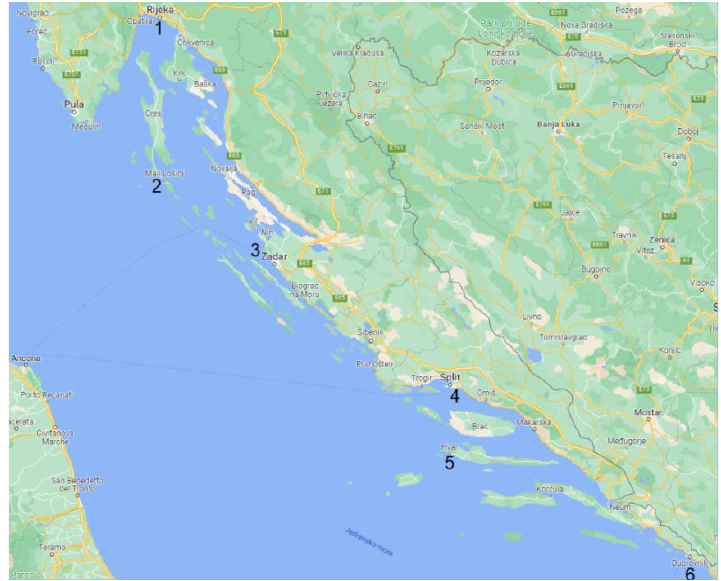
Figure 6. Six investigated locations on the Croatian side of the Adriatic Sea [57].